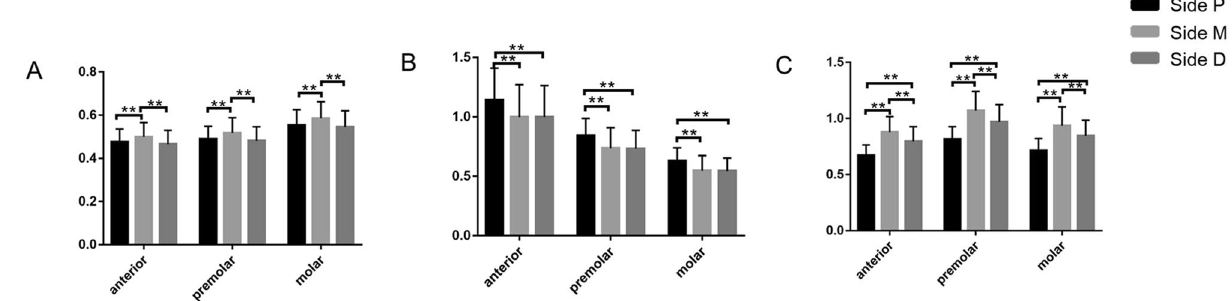
Figure 2. The ratio of height (widths) of each section of fibula to height (width) of different areas of mandible: ( A ) The ratio of height. ( B ) The ratio of W1. ( C ) The ratio of number of fibula segments and perforators of skin island as well as pedicle orientation and length, anatomi- cal studies concerning mandibular or fibular morphology were performed to achieve aesthetic and functional outcomes 5–8 . Our morphometric study differed from previous reports by the methodology used. From clinical observations, one person’s mandible and fibula show the same size trend; however, few studies compared the morphology of fibulae and mandible in the same individuals, which was the major advantage of the present study, consisting of a total of 118 paired fibula and mandible in a Chinese population. Also, the similarity of contour in paired fibula and mandible was analyzed in order to choose the optimal segment of fibula for mandibular reconstruction. Appropriate assessments of graft morphology and optimal bone contour restoration are required to improve symmetry of the lower facial profile, which could be discriminated within the range of millimeters 9,10 . A recent study compared contour restoration of mandibular body defects with “Single shot” and osteotomized fibula flaps (SS-FF and O-FF), iliac crest flaps (ICF) and scapular tip flaps (STF), and demonstrated that O-FF performed best in contour conformance with native mandible 11 . The cross-sectional shape of the fibula at different sites was usually discussed in previous studies. According to the classification of Fujisawa et al. 12 , the cross-sectional shape of fibula on CT images could be divided into 4 types: knife-edged, triangular, circular, and square. Due to different sites concerned, the shapes of the cross-sections at middle of fibula were categorized into three types: triangular, quadrilateral, and irregular 13,14 . In addition to the shape of mandible, German et al. 15 defined posterior mandibular ridge morphology as 5 types: straight, oblique, s-shape, hourglass, and basal bone. The main purpose of these reports was to determine the possibility of inserting dental implants. As a matter of fact, it could be better to restore the mandible defect in accordance with its original morphology. As shown in Table 2, by virtue of the cross-sectional shapes, 90.82% of mandibular anterior area presented S-shape, and could be best reconstructed with Side M of fibula, 67.8% of which showed triangular shape. The secondary option was Side D of fibula, with 49.2% of triangular. If the mandibular defect occurred in premolar area, 83.64% of which was straight, the best choice was Side P of fibula with 75.4% of circular, or Side D of fibula with 40.7% of square. Mandibular defect of molar area with 91.89% of oblique, could be preferred by Side P of fibula with 75.4% of circular, or Side D of fibula with 40.7% of square. These results indicated that the similarity in cross-sectional shape between fibula and mandible should be evaluated preoperatively, which could provide additional information in fibula harvesting. Fibula could provide adequate length but limited height or bone thickness in comparison with ilium 5,16 . Since the vertical height of fibula was shorter than that of native mandible, it was recommended to place transferred fibula on the lower edge of mandible to improve cosmesis, or on the upper edge of mandible to reduce the implant height. Thus, the height deficiency of free fibular flap renders the dental implant insertion into reconstructed mandibles to be one of the most challenging procedures for occlusal rehabilitation. According to our results, the height of fibula at Side M was significantly larger than that of Side D and Side P (Table 3). Moreover, the H (Side M/area) was significantly larger than that of H (Side D/area) and H (Side P/area) (Fig. 2A). All these results proved that the middle of the fibula was the optimal segment for mandibular reconstruction in term of bony height. Even so, it should be recognized that the height of the middle of the fibula was only half of the height of the naive mandible, which could be solved in following ways. Double-barrel technique of the fibula in the primary surgery or vertical osteodistraction of the integrated fibula flap in the secondary surgery was also reliable but drove the surgeons to a complicated surgery scenario 17,18 . Sun et.al proposed a convenient free bone grafting method using nonvascularized fibula as an inlay graft to the lower border of the neomandible 19 . Recently, a novel reconstructive customized plate was projected to support the fibular flap at an alveolar bone position above the typical inferior mandibular border 20 . This reconstructive proposal appears to be a valid alternative to restore the vertical height of the reconstructed mandible, and it could be better if the customized plate was combined with optimal fibula segments. In addition to height, it was evidenced that fibula showed variable bone dimensions and some sites presented inadequate width for dental implants 5 . A digital imaging study suggested that the width of the central section of fibula was the largest compared with that of lateral malleolus and head of the fibula. Moreover, with respect to the available length with adequate bone volume for dental implants, the length near the lateral malleolus was larger than that near the head of fibula 14 . However, our data suggested the maximum of W1 was located at Side